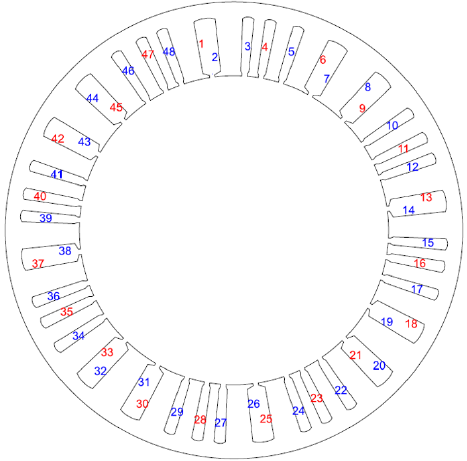
Figure 3. Rotor unsymmetrical slots.